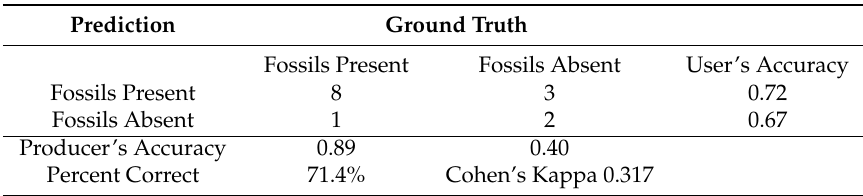
Table 6. Results of 2014 field season from the Dugout Draw area using the Landsat 7 ANN-based predictive